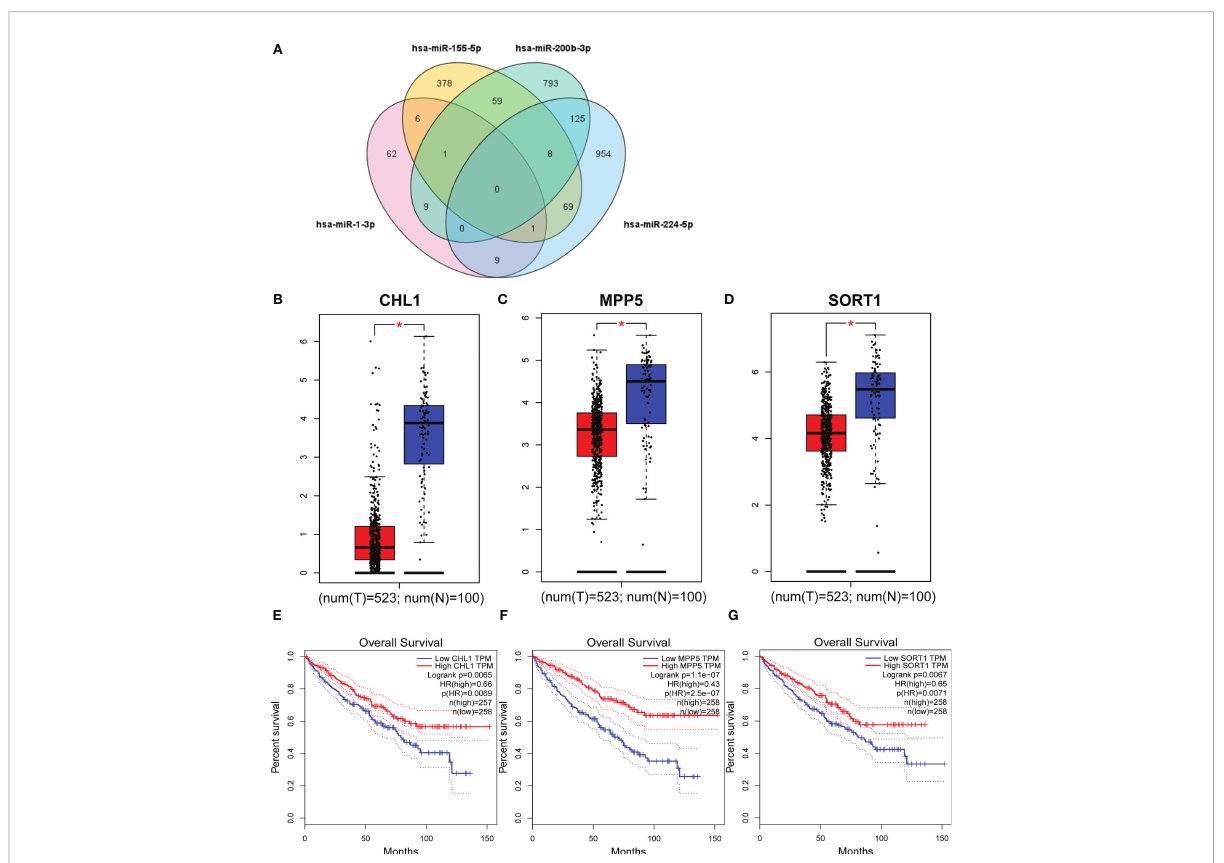
FIGURE 5 Target genes and overall survival of target genes. Genes that were predicted in over two miRNAs were regarded as potential targets, and eventually, 278 genes were elected (A) . GEPIA was applied to predict these genes relating to four candidate miRNAs in 523 RCCs and 100 NCs. CHL1 (B) , MPP5 (C) , and SORT1 (D) were dysregulated with |log2FC| > 1and p < 0.01. CHL1 (E) , MPP5 (F) , and SORT1 (G) were associated with the prognosis of RCC. T, tumor; N, normal control. *p <0.01.